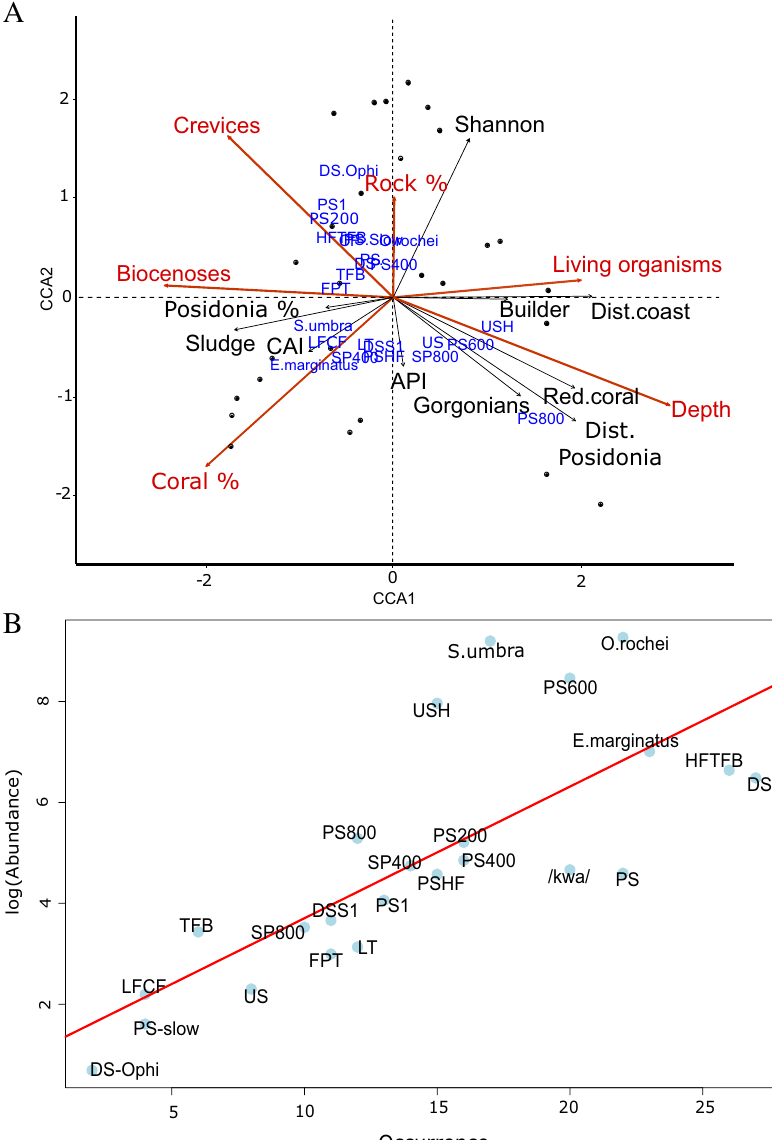
Figure 2. ( A ) Canonical correspondence analysis ordination plot of the acoustic community composition of coralligenous reefs based on Bray–Curtis dissimilarities of relative abundances of N = 24 sound types (blue) at 27 sampling sites (black dots) showing the influence of all environmental variables (arrows, c.f. Table 1), including the most relevant ones used for model testing (in red). Builder = Structuring species, Posidonia % = percent of Posidonia oceanica , Rock % = percent of rocky substrate, Coral %: percent of coralligenous outcrops, Dist. Posidonia = Distance from the closest P. oceanica meadow. ( B ) Occupancy-abundance plot showing the abundance of sound types across all sites. Sound types on the top right are those that are more common, while those on the bottom left occur only at a few sites (c.f., Supplementary Tables S2 and